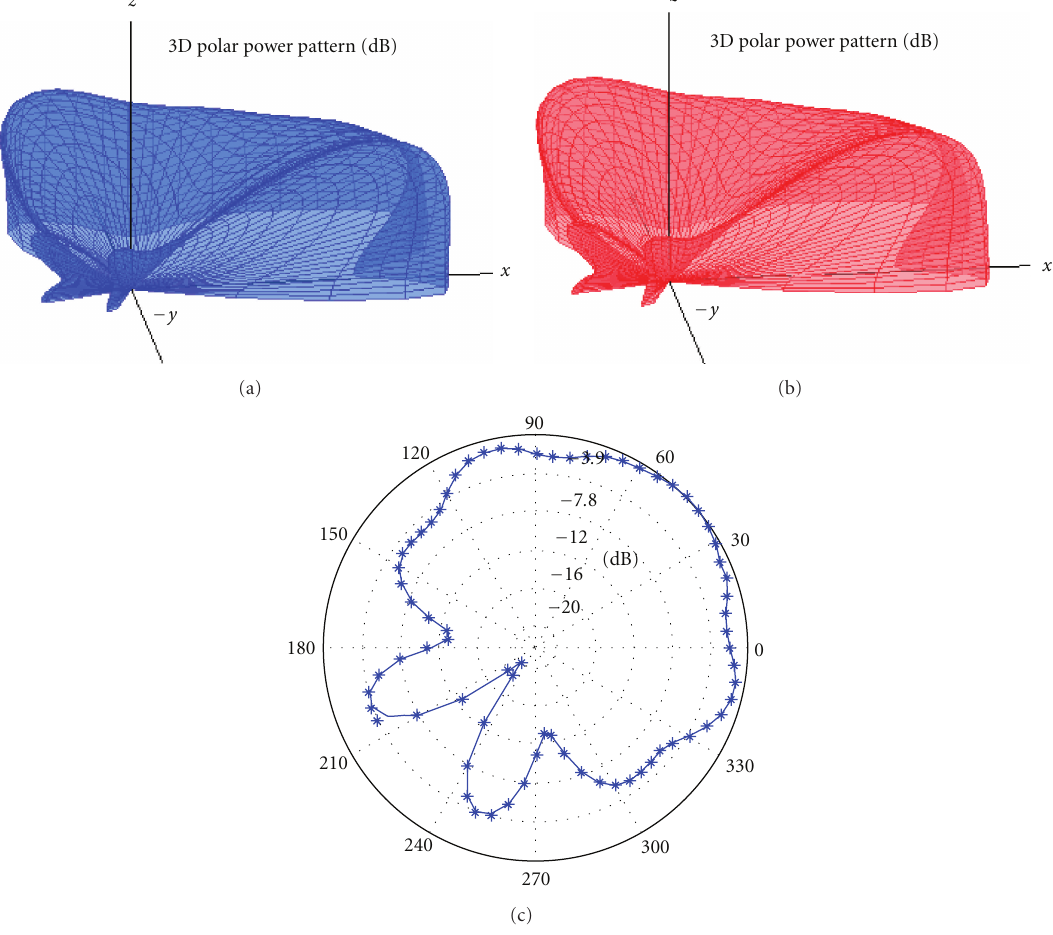
Figure 4: Results for a monopole array, radius 10.5 cm, at 5GHz. (a) 3D Polar representation of normalized power pattern calculated as a whole block. Values 10dB below maximum are not represented. (b) 3D Polar representation of normalized power pattern calculated from the GSM of an isolated monopole. Values 10 dB below maximum are not represented. (c) Comparison of both cases on the azimuthal